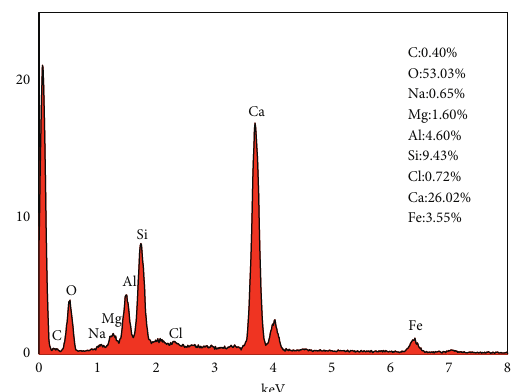
Figure 12: EDS spectrum of GO0 after 100 salt-frost